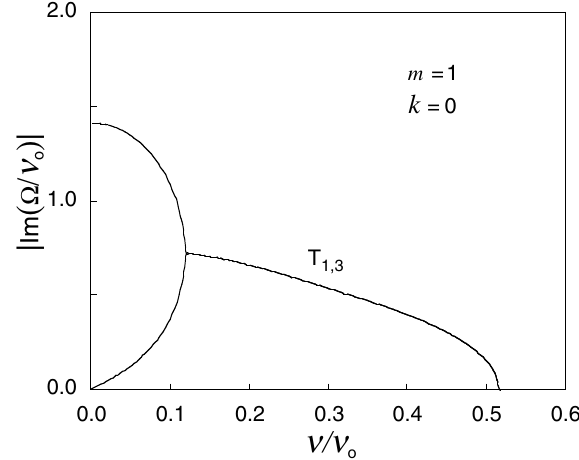
FIG. 3. Absolute value of the imaginary part of (cid:13) =(cid:10) first nine dipole modes as a function of (cid:10)=(cid:10) b=a (cid:3) 1 : 5 . Here, only the modes with none-zero Im (cid:1) (cid:13) =(cid:10) labeled.